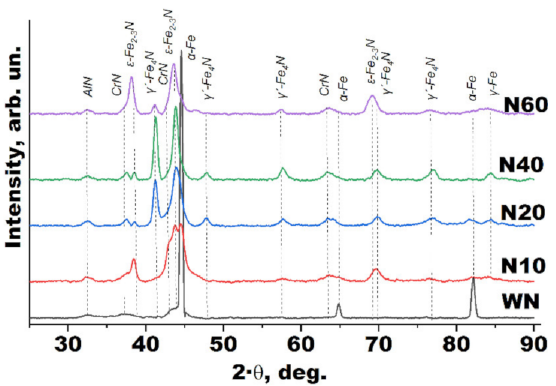
Figure 2. XRD patterns of AISI 420 samples after duplex treatment with the PN duration of 10 (N10), 20 (N20), 40 (N40), and 60 (N60) min. The WN sample is the AISI 420 substrate with CrAlN